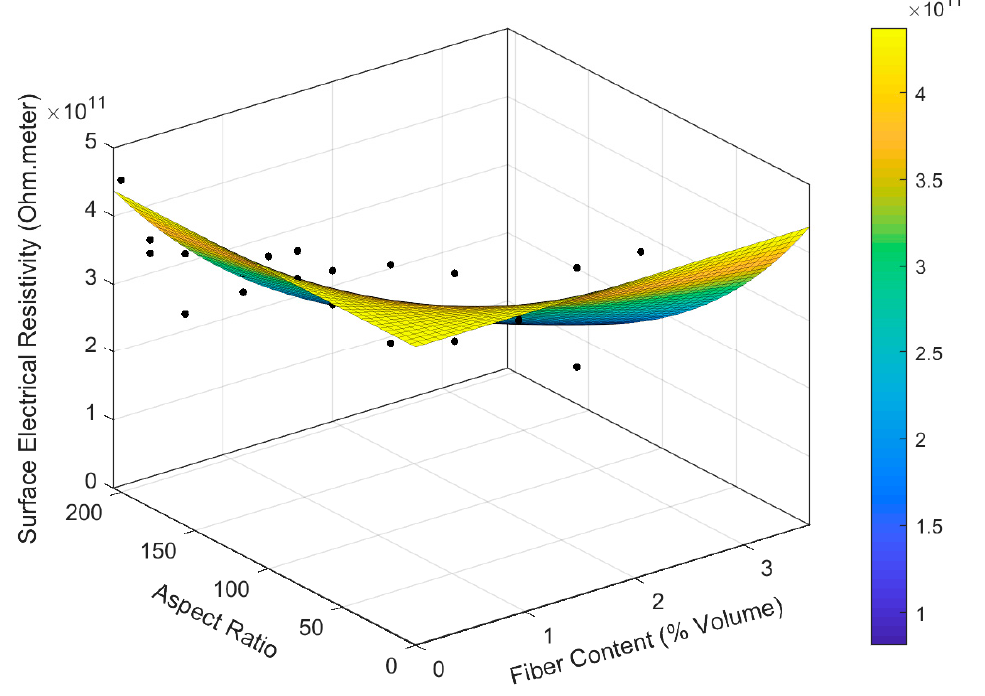
Figure 7. The electrical resistance for different percentages of fiber content. Table 4. Formulation of experimental and numerical results trends.